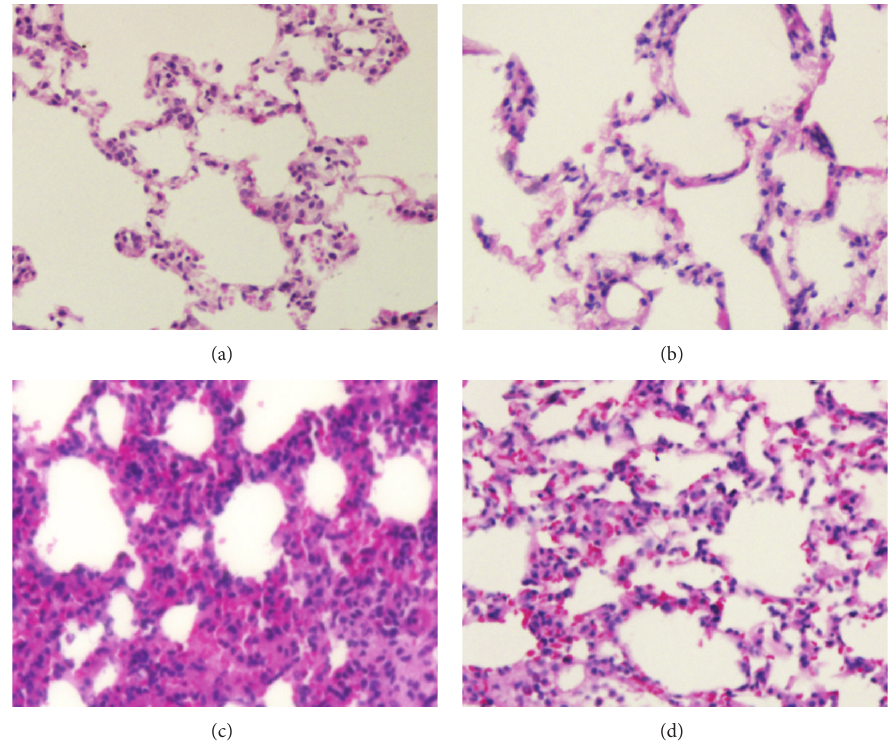
Figure 4: Effect of EGCG pretreatment on the histopathologic changes in lungs in seawater aspiration-induced ALI: (a) control group: the lung structure was normal; (b) EGCG (10mg/kg) group: there was no obvious change in lung structure compared with control group; (c) seawater group (4mL/kg): alveolar wall thickened, edema and hemorrhage, less alveolar space and obvious inflammatory cells infiltration into interstitial and alveolar spaced; (d) seawater (4mL/kg) + EGCG (10mg/kg): lung injury was significantly alleviated compared with seawater group (hematoxylin and eosin staining, original magnification 200 × ).